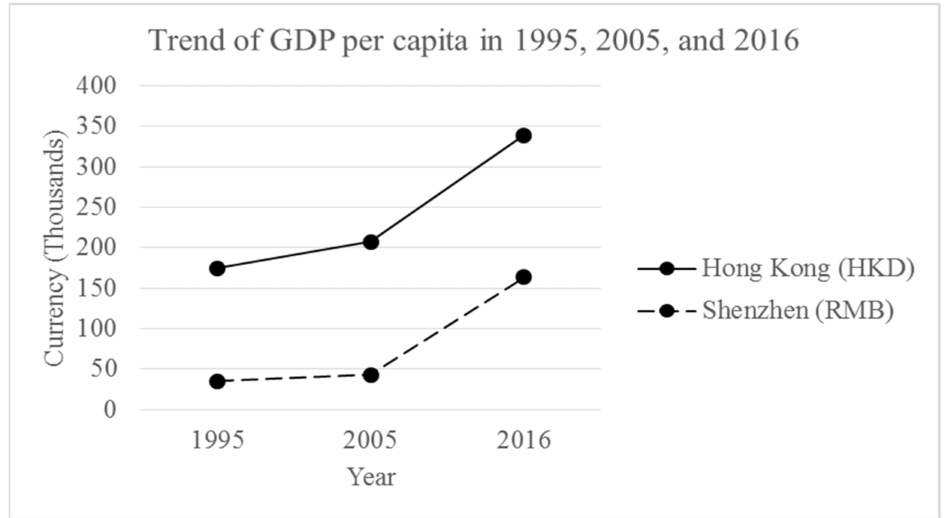
Figure 18. Trend of GDP per capita in 1995, 2005, and 2016. Table 6. Population, GDP, GDP per capita of Hong Kong and Shenzhen in 1995, 2005, and 2016.